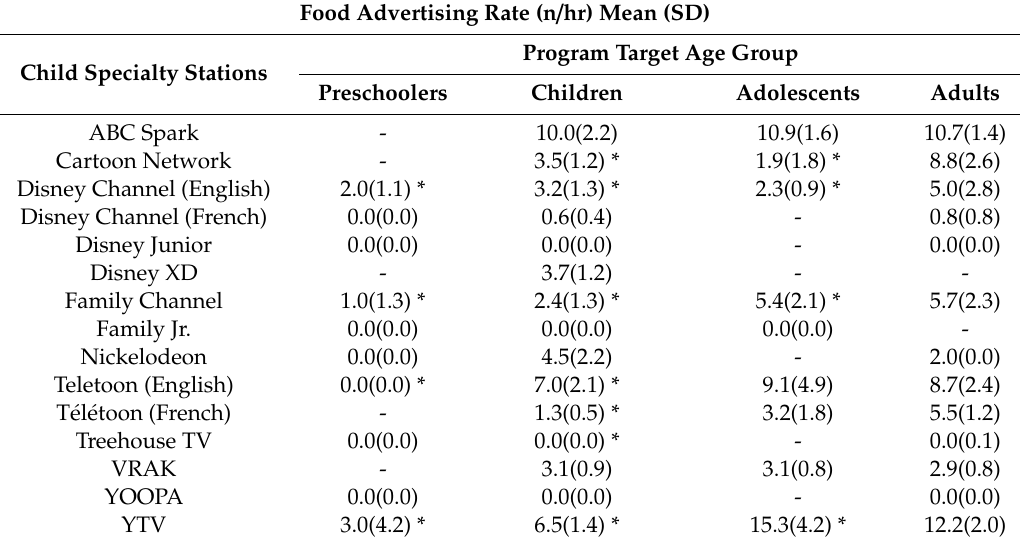
Table 2. Average age-specific rates of food advertising (n / hr) across 15 Canadian child-specialty television stations 1 , in